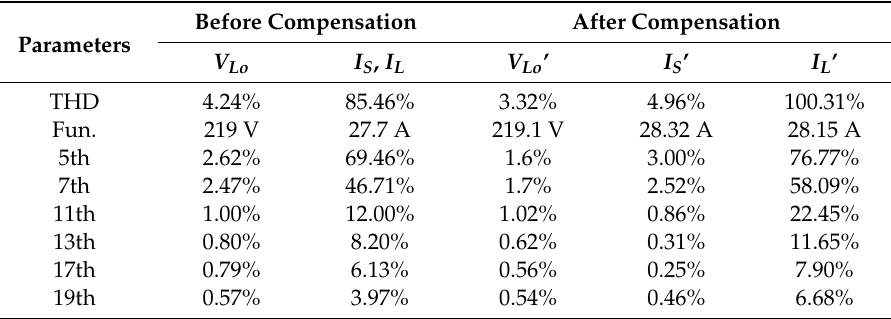
Table 1. Simulation results of series 100 μ H inductors.